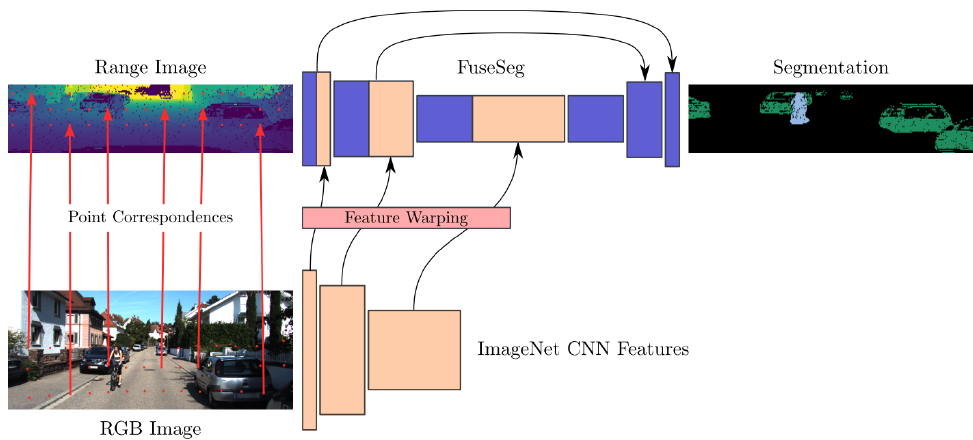
Figure 14. Figure from [118] that explains the FuseSeg-LiDAR architecture. Reprinted with permis- sion from the authors of [118]. Copyright 2020,